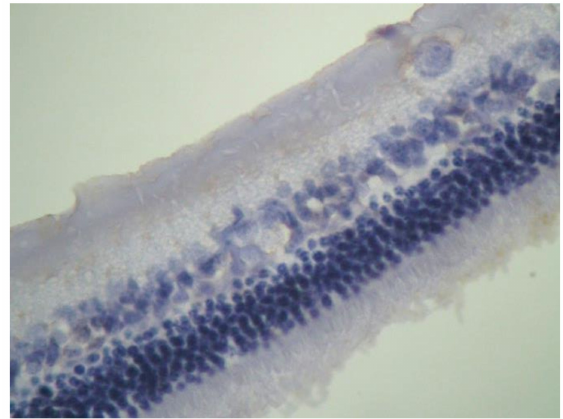
Figure 13. Group M. Negative ( − ) immunohistochemical staining. IL-6. × 160.